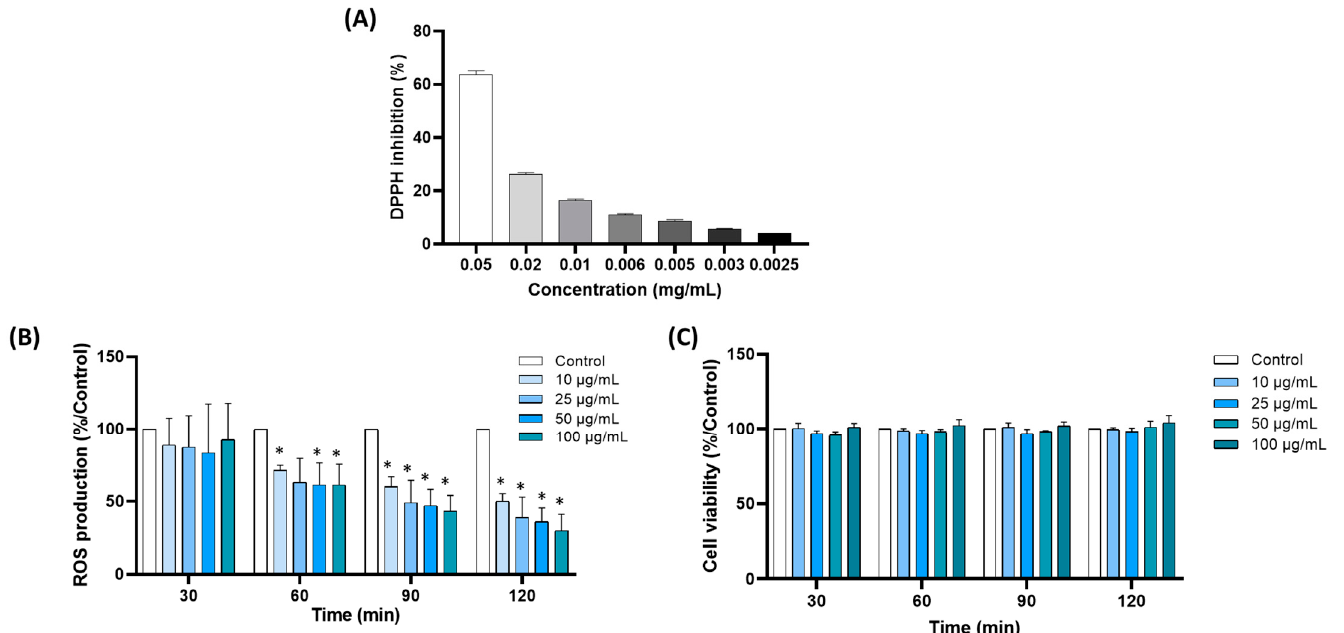
Figure 1. Antioxidant activity of Rooibos extract. ( A ) Free-radical scavenging activity toward DPPH radical; ( B ) production of ROS by blood leukocytes with different concentrations of Rooibos. Cells were incubated with Rooibos extract (0, 10, 25, 50 and 100 µg/mL) and stimulated with PMA (1 µM). Data shown as mean ± SD; ( C ) effect of Rooibos extract on leukocyte viability. Cells were treated with the indicated concentrations of Rooibos for 2 h, and then cell viability was measured. Data shown as mean ± SD (control corresponded to stimulated untreated cells = 100%); * p < 0.05 compared with control.